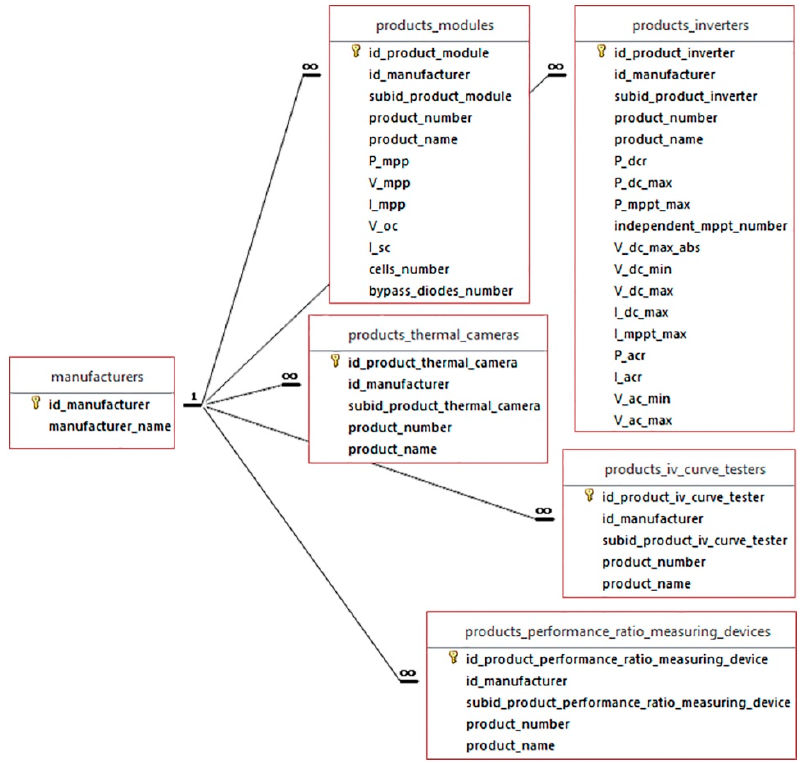
Figure 8. The products group of the conceptual model implemented into the relational database.